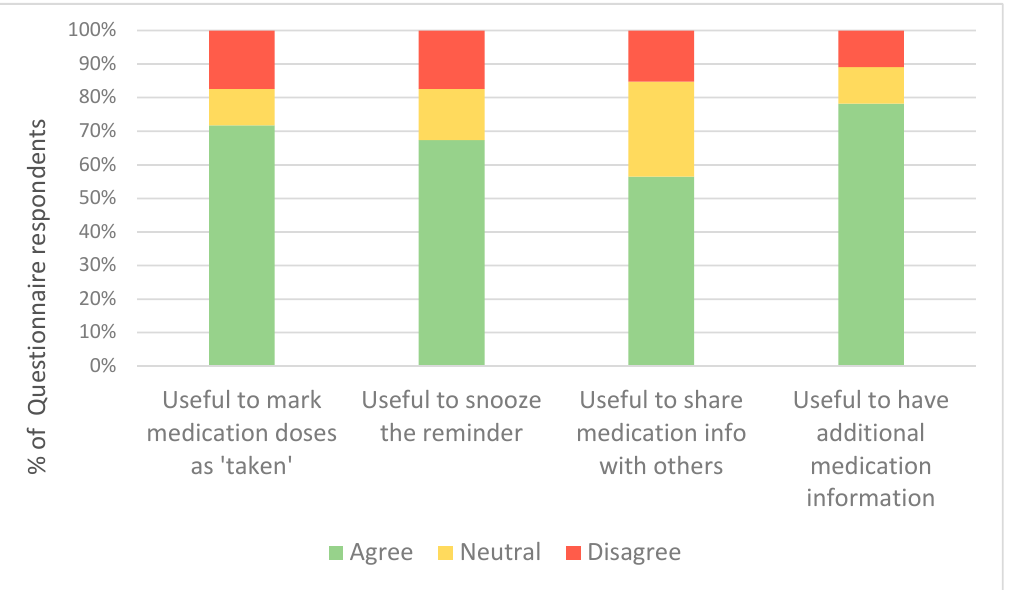
Figure 5. Additional feedback questionnaire responses in the advanced medication reminder app group.